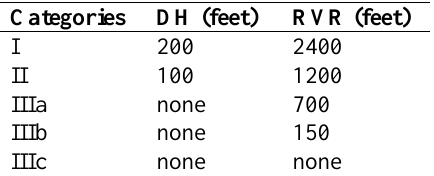
Table 3. ILS minima in decision height* and runway visual